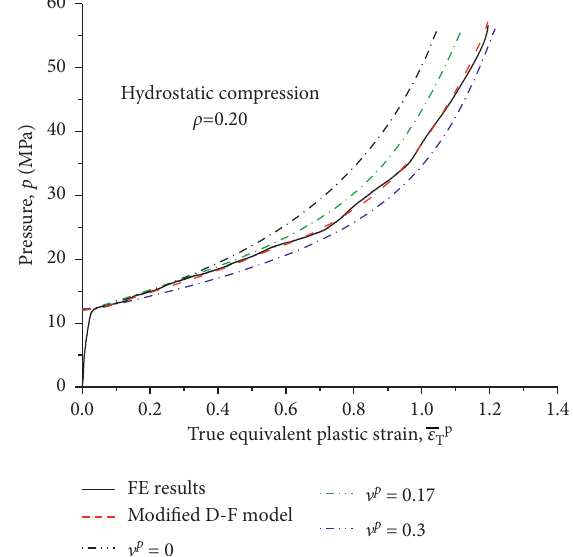
Figure 20: Predictions of the pressure under hydrostatic com- pression according to the first-type D-F model and the modified D- F